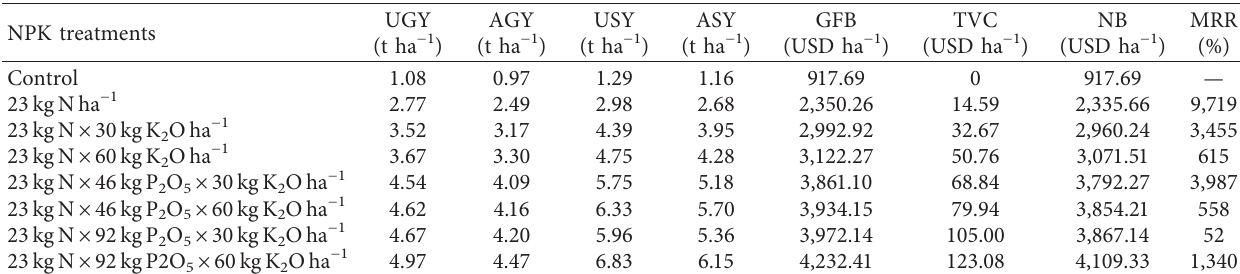
Table 11: Mean marginal rate of return of faba bean influenced by N, P, and K fertilizers. UGY NPK treatments